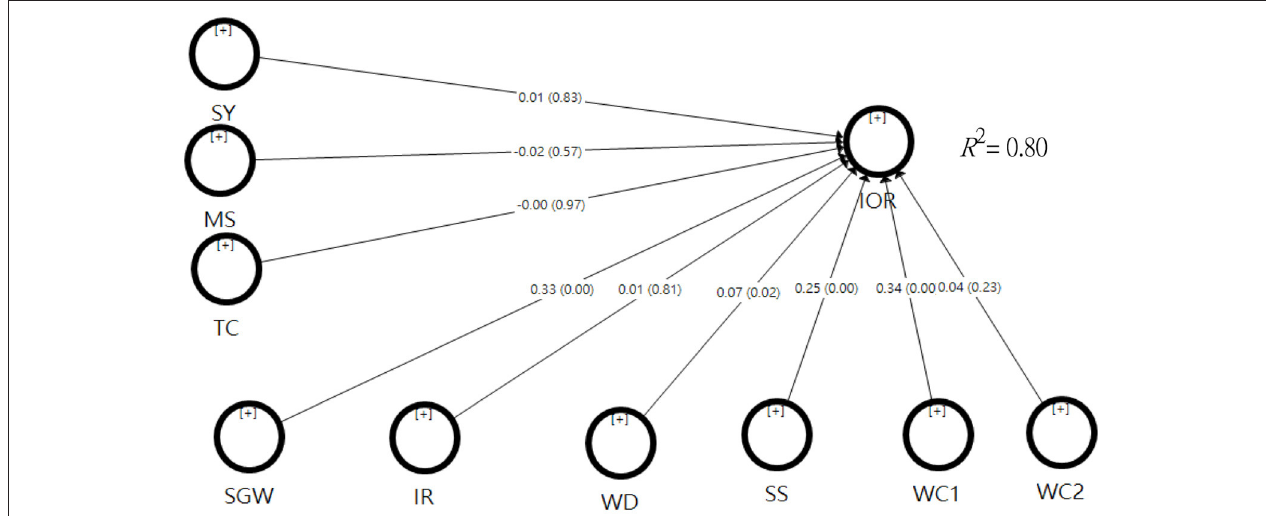
FIGURE 4 | Test results of the individual psychological factors hypothesis